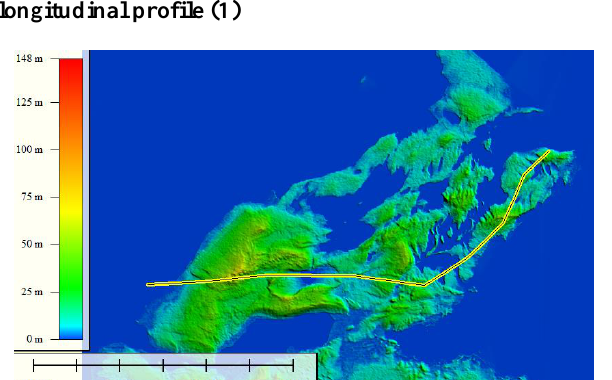
Figure 14. the graph of longitudinal profile (1)